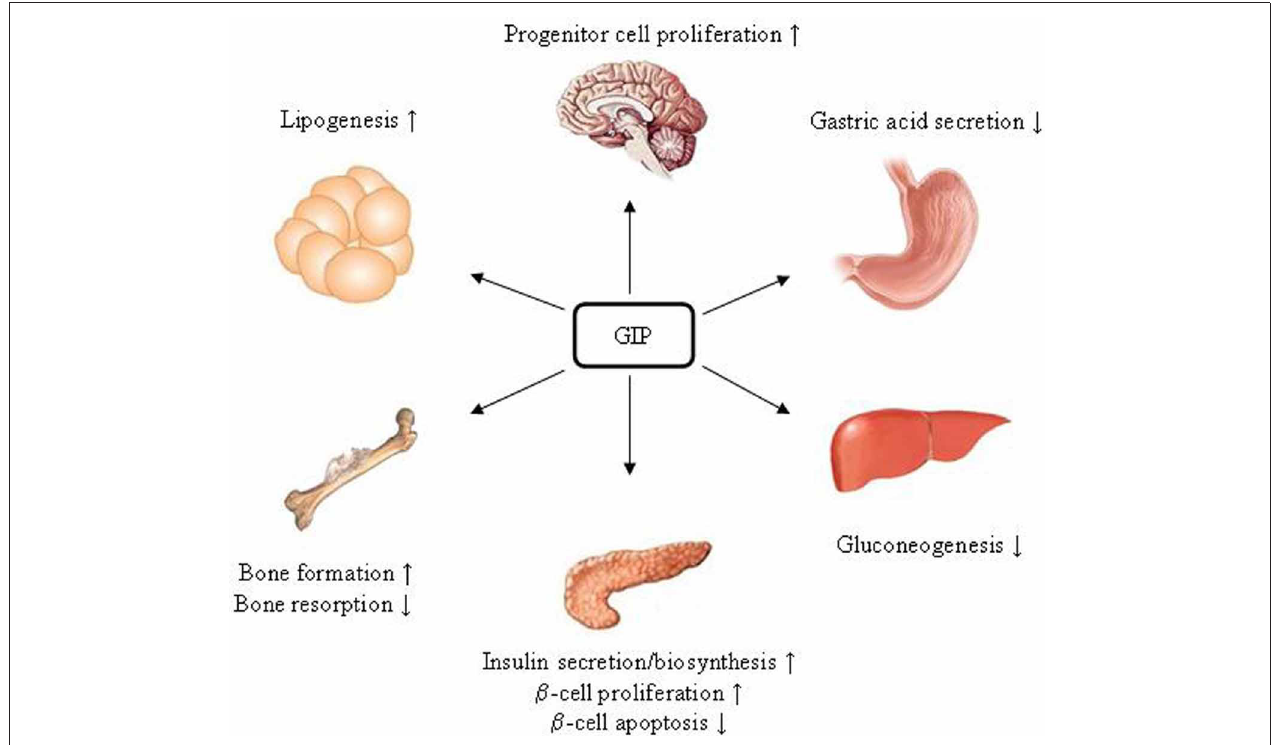
FIGURE 4 | Schematic presentation of GIP. Since GIPR has not been detected in hepatic cells, the effect of GIP on reducing gluconeogenesisis likely due to an indirect